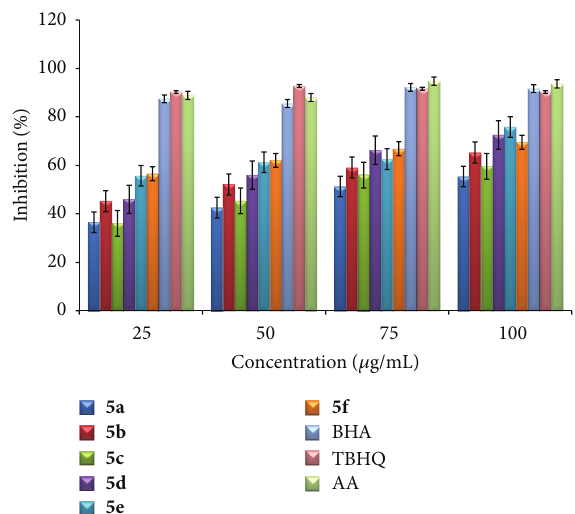
Figure 6: Metal chelating activity of compounds ( 5a–f